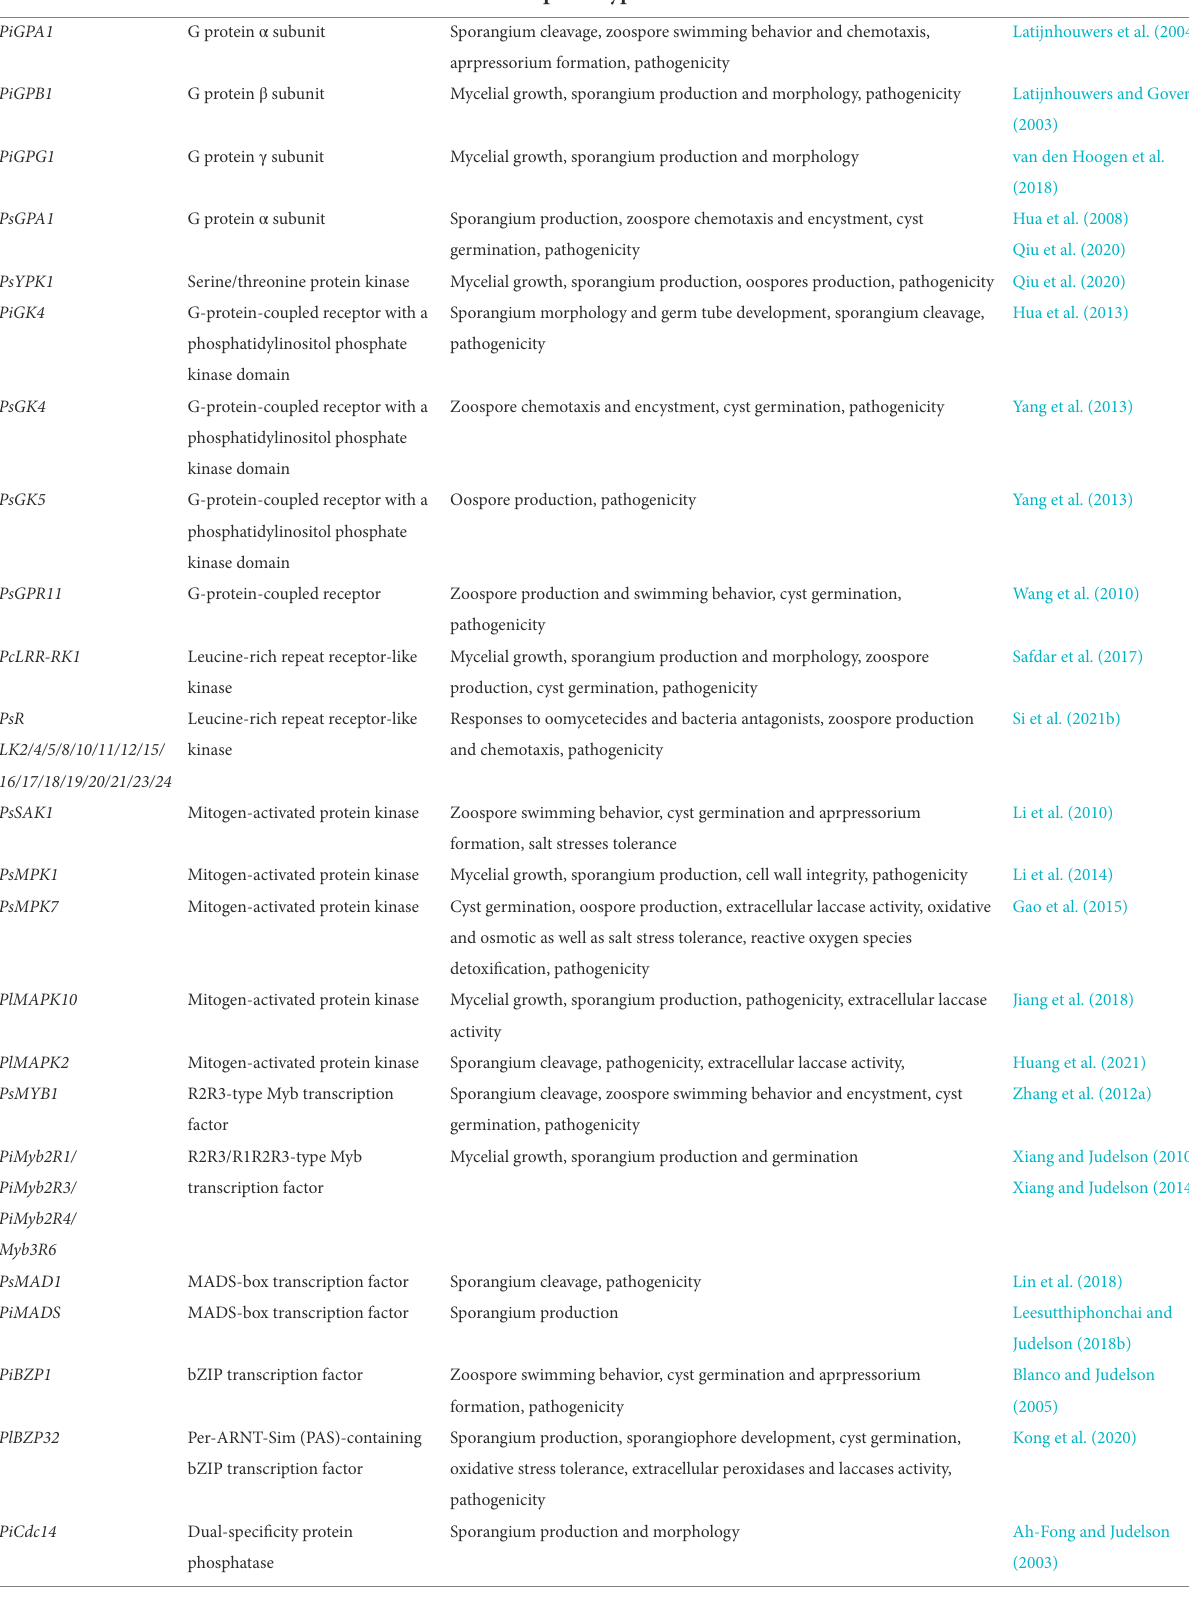
TABLE 1 Sporulation-related genes discussed in this